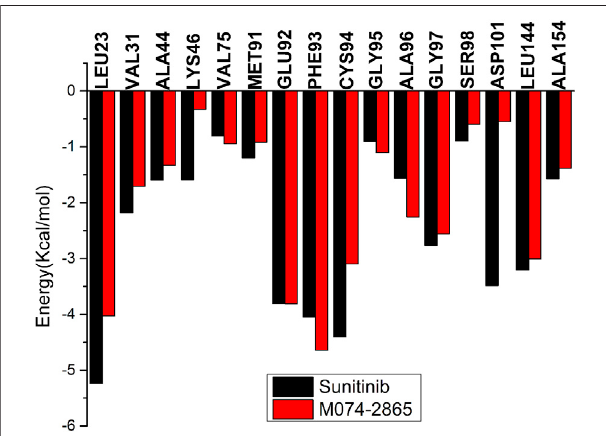
FIGURE 6 | Total energy contribution comparison of HPK1 inhibitors binding to key